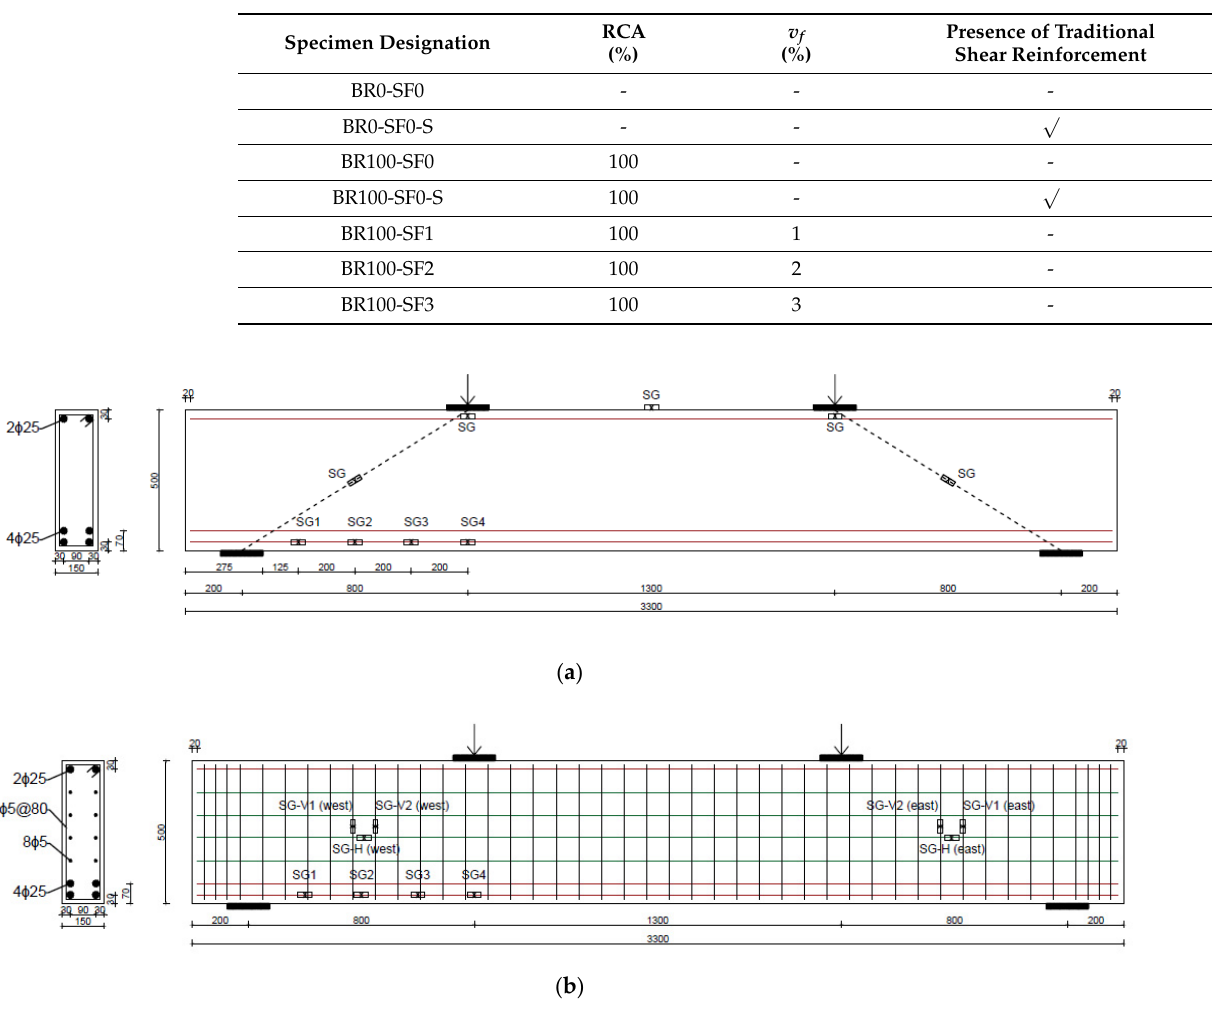
Figure 3. Details of deep beam specimens (dimensions are in mm): ( a ) a beam without traditional shear reinforcement; ( b ) a beam with traditional shear reinforcement.